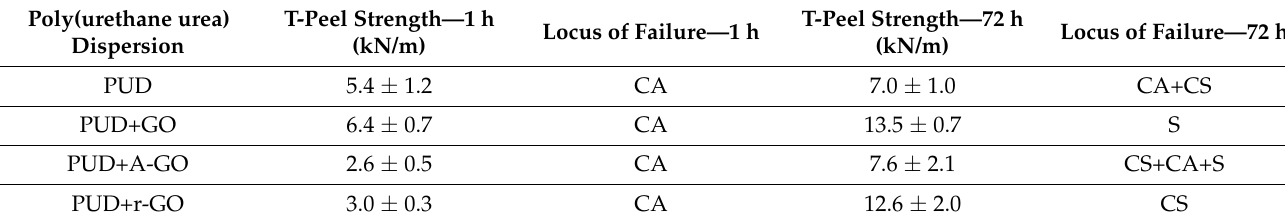
Table 12. T-peel strength values of the plasticized PVC/PUD without and with GO derivative/plasticized PVC joints obtained 1 and 72 h after joint formation. Locus of failure: CS—Cohesive failure of the substrate surface; CA—Cohesive failure of the adhesive; S—Rupture of the PVC